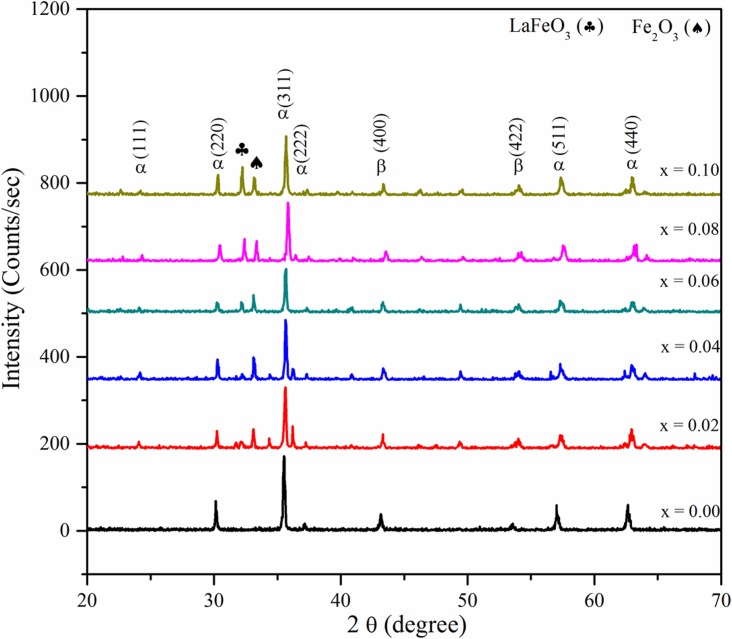
Structural and grain size analysis of La3+ substituted Ni-Zn ferrite nanoparticle.XRD diffraction patterns for the sample of Ni0.5Zn0.5LaxFe1-xO4 nanocrystalline (α: Ni-Zn ferrite; β: iron oxide) at various La+3 substituted concentration.